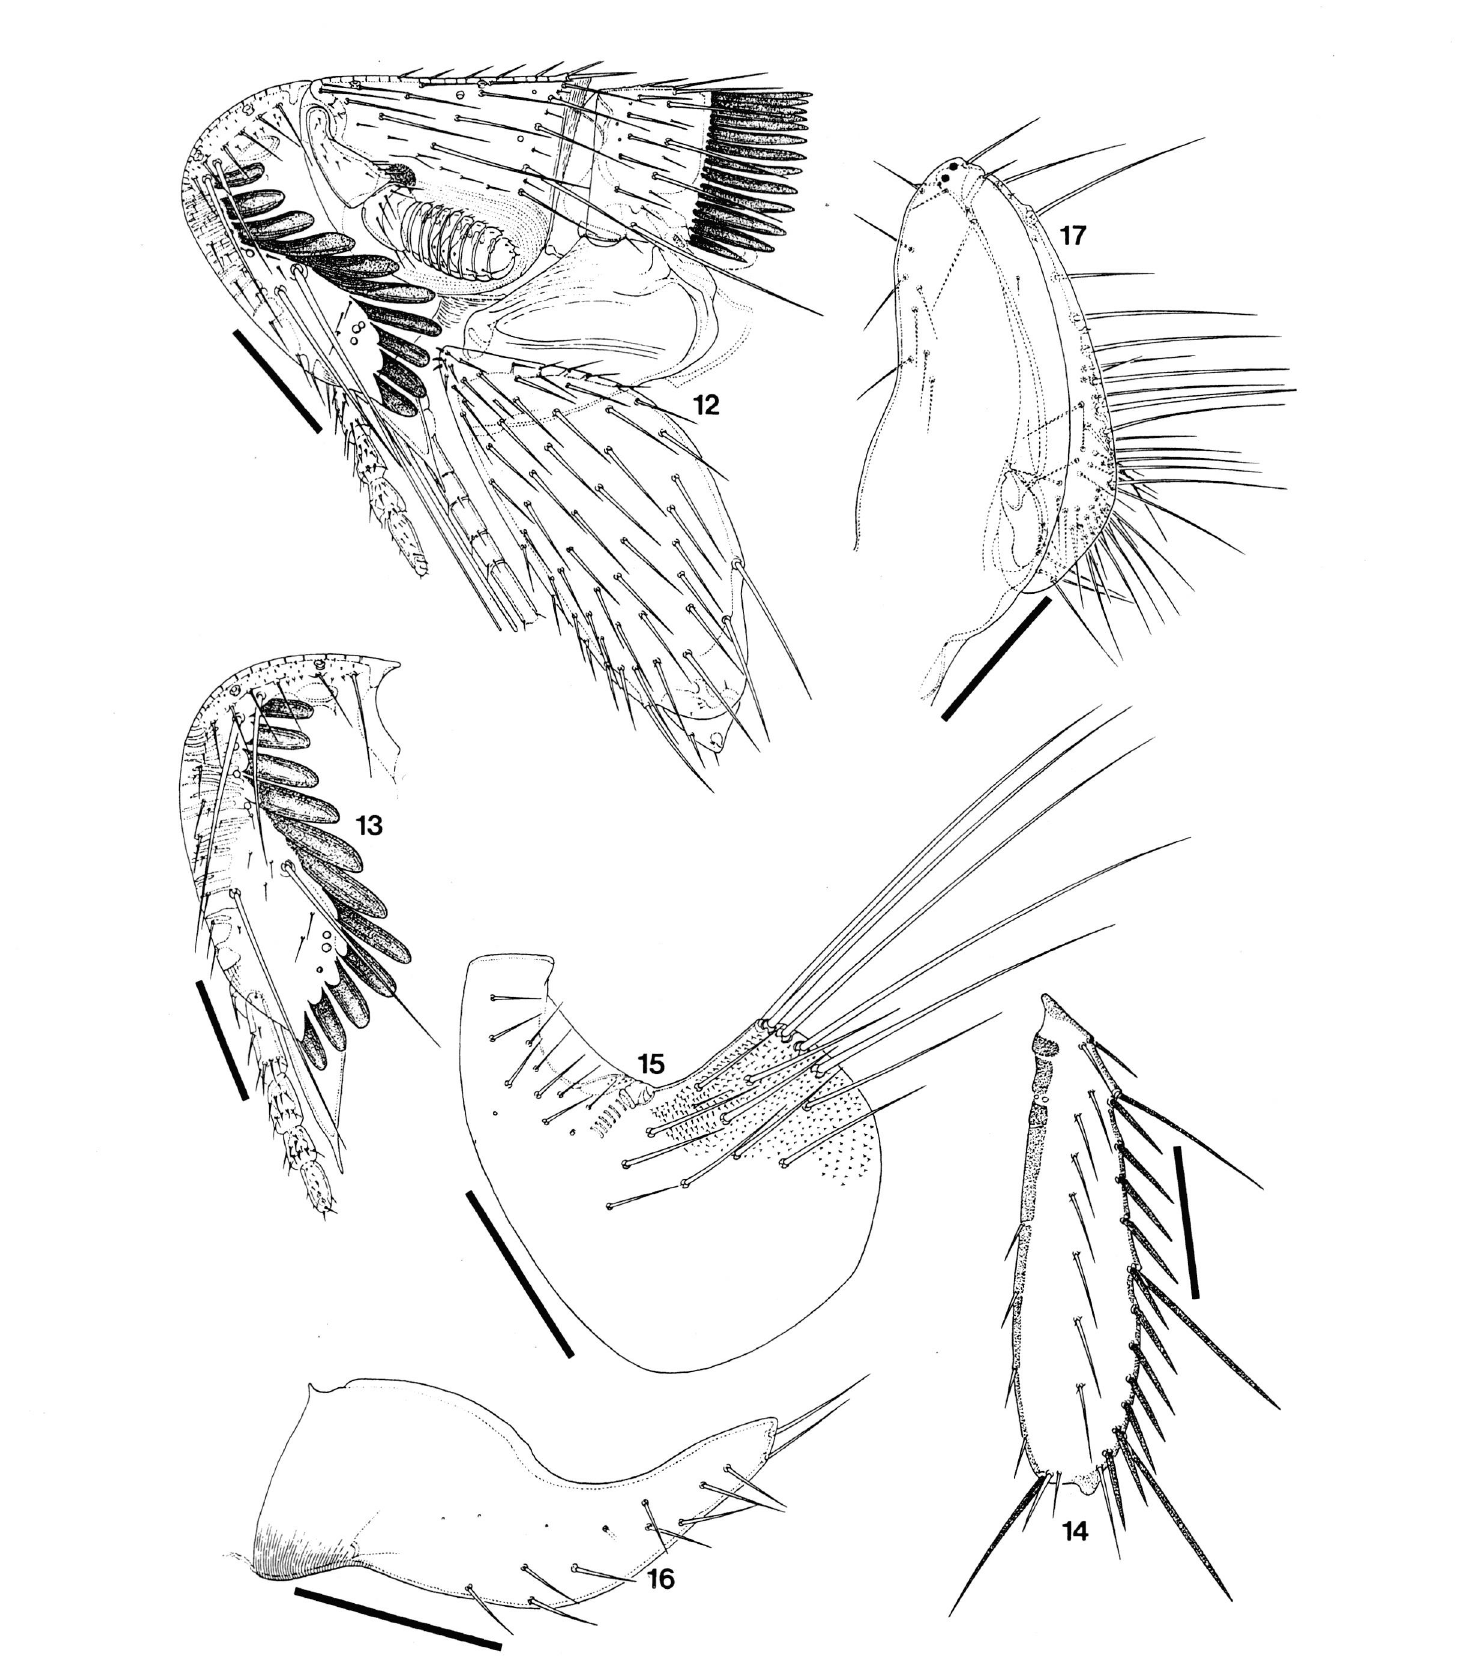
Figs 12-17. - Sigmactenus alticola pilosus n. ssp. 12: Head, prothorax and adjacent structures of male. 13: Head of female. 14: Tibia III of female. 15: Tergite VIII of male. 16: Sternite VIII of male. 17: Tergite IX of male. All scale bars = 0,1 mm. Parasite, 2000, 7,